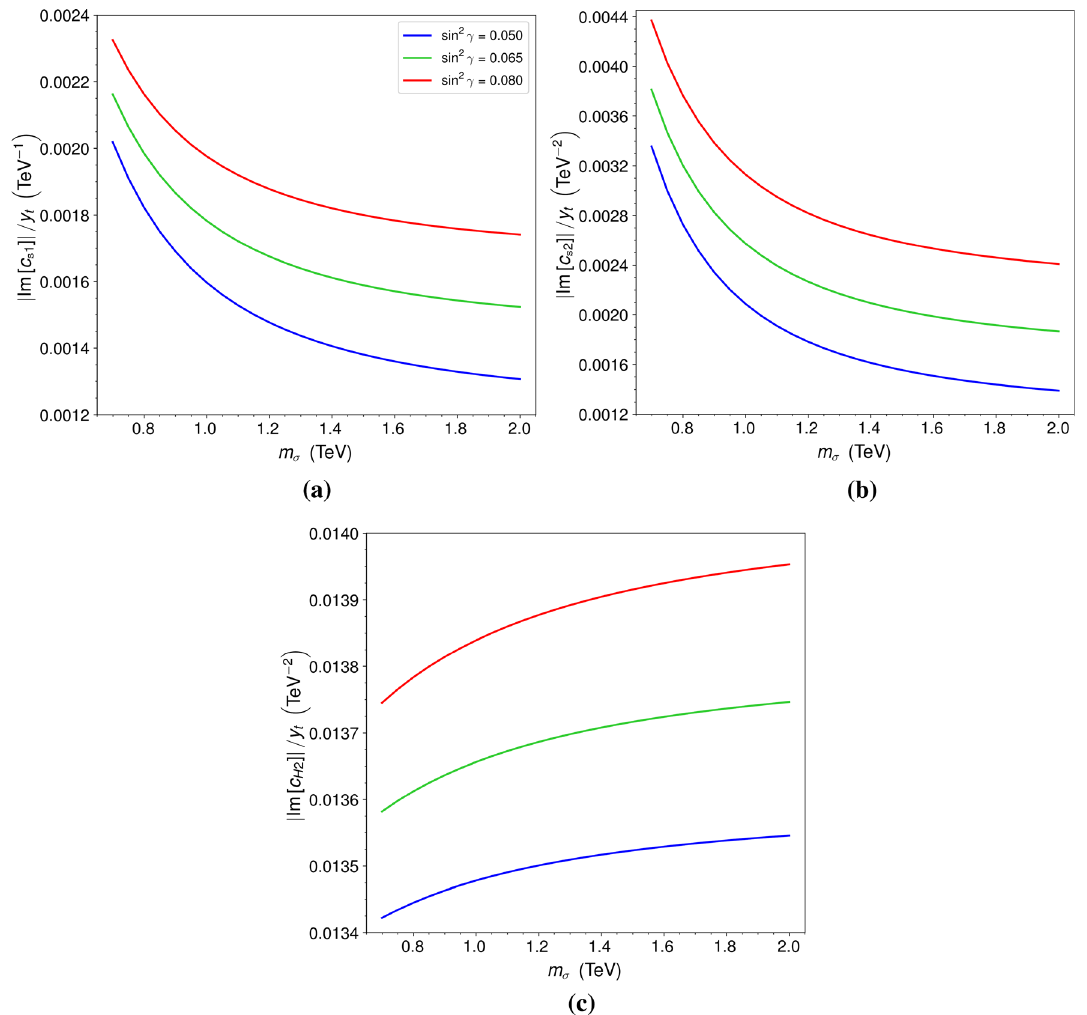
(cid:14) (cid:14) (cid:14) (cid:14) (cid:14) (cid:14) (cid:14) Im [ c t (cid:14) / y (cid:14) Im [ c t (cid:14) / y (cid:14) Im [ c t (cid:14) / y ] ] ] t (a), t (b)and t (c),assumingthecontribution s 1 s 2 H 2